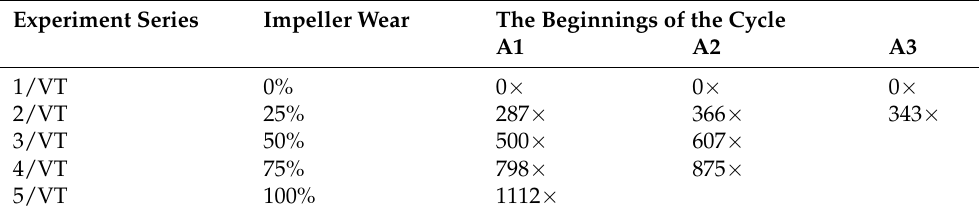
Table 4. Course of operational tests and rotor wear values for all